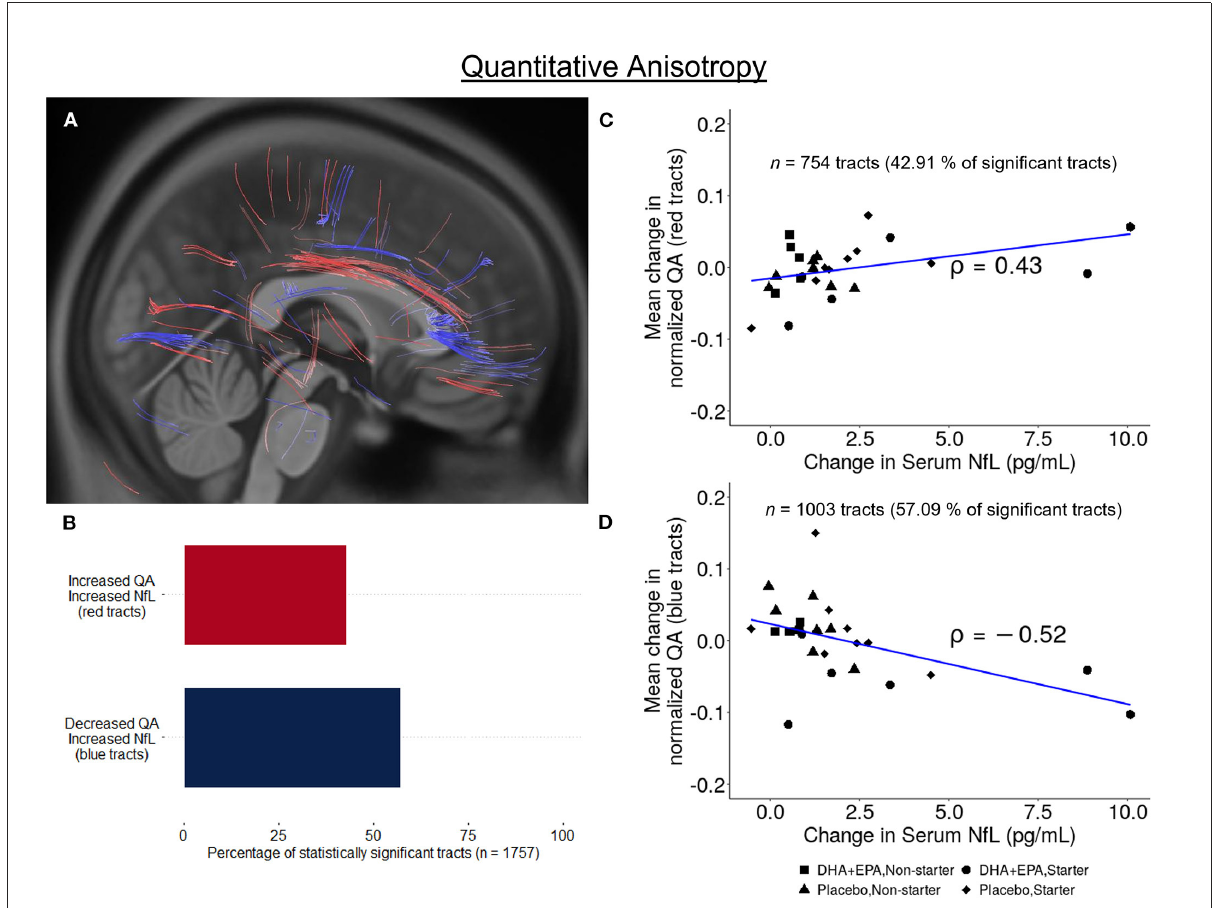
FIGURE7 Association between change in serum NfL and white matter structural connectivity. A total of 1,757 tracts exhibited a statistically significant correlation between change in quantitative anisotropy and change in serum neurofilament light (NfL) from baseline to end of season. 42.91% of these tracts exhibited a positive correlation ( n = 754, FDR corrected p < 0.003; A red-colored tracts; (B,C) ] while 57.09% exhibited a negative correlation [ n = 1,003, FDR corrected p < 0.0004; A blue-colored tracts; (B,D)